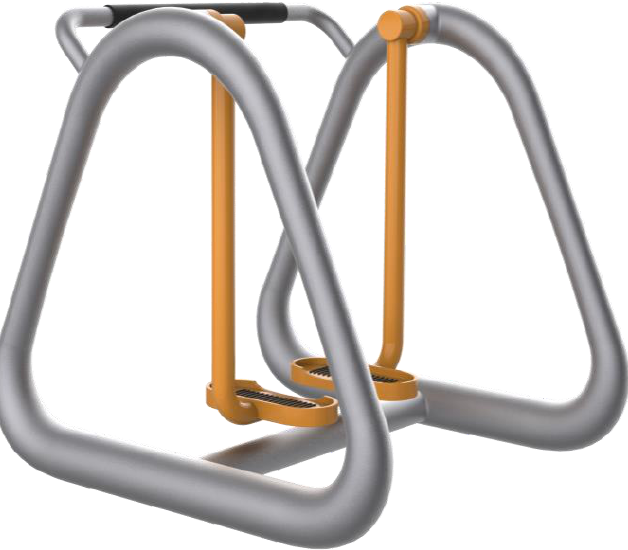
Figure 4. The overall structure of the walker.